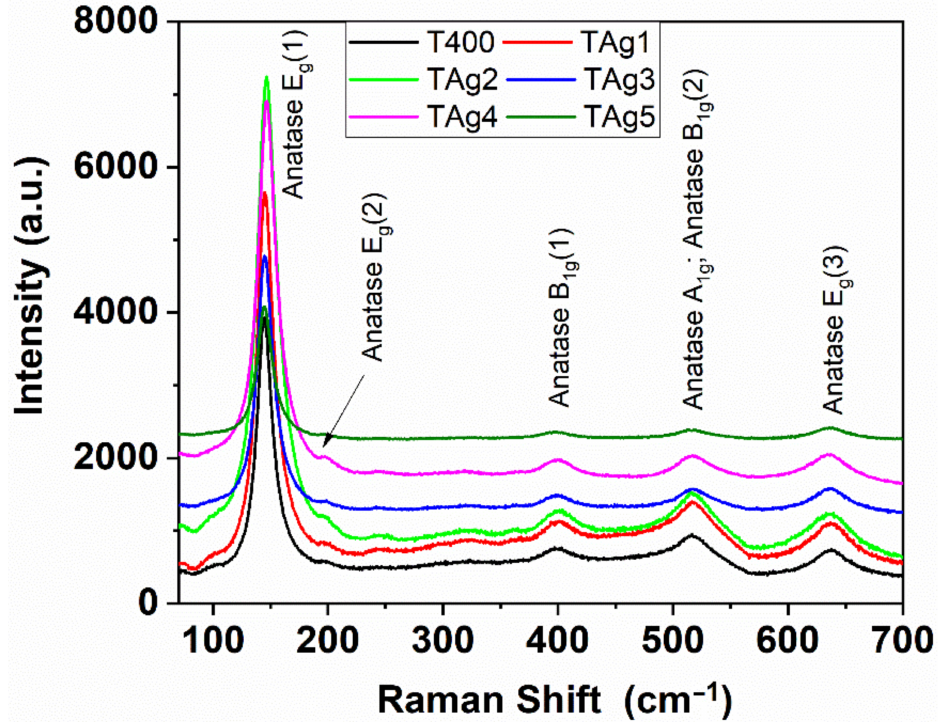
Figure 5. Raman spectra of pure TiO 2 and Ag–TiO 2 nanostructured nanofibers